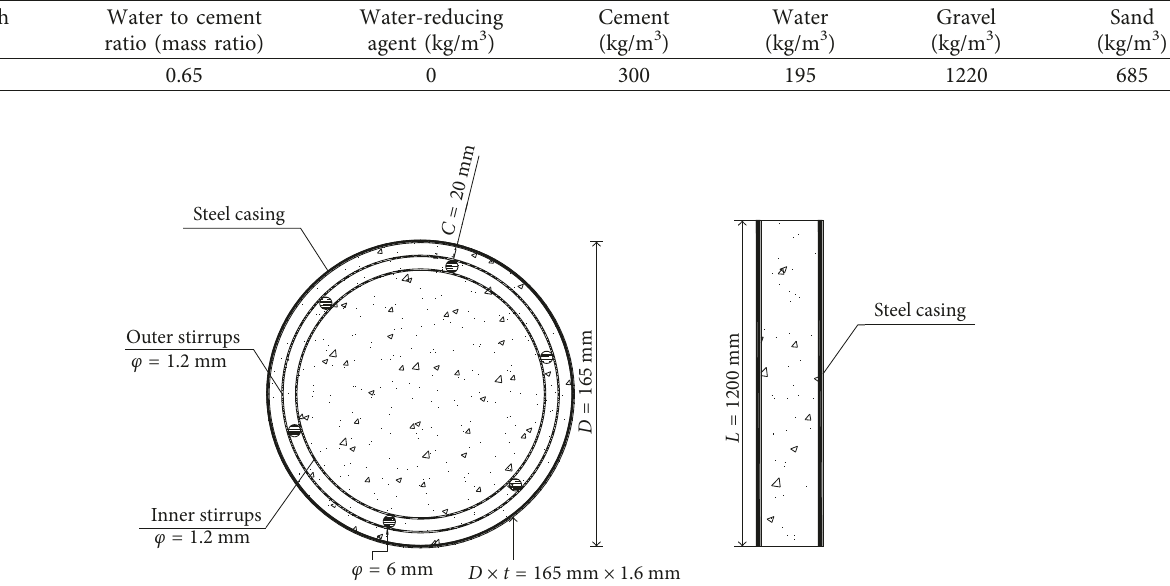
Table 1: Concrete mix design.